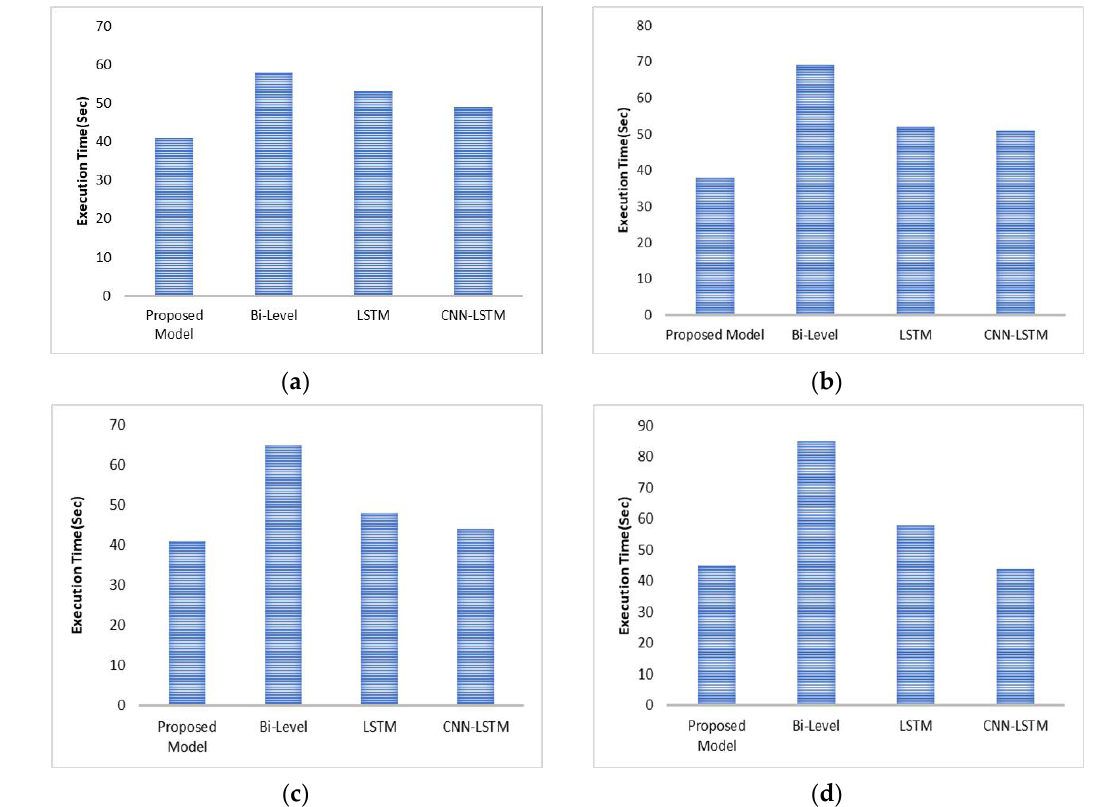
Figure 9. Comparative analysis of proposed model with respect to time execution. ( a – d ) shows the execution time of four different test results respectively for four grids.